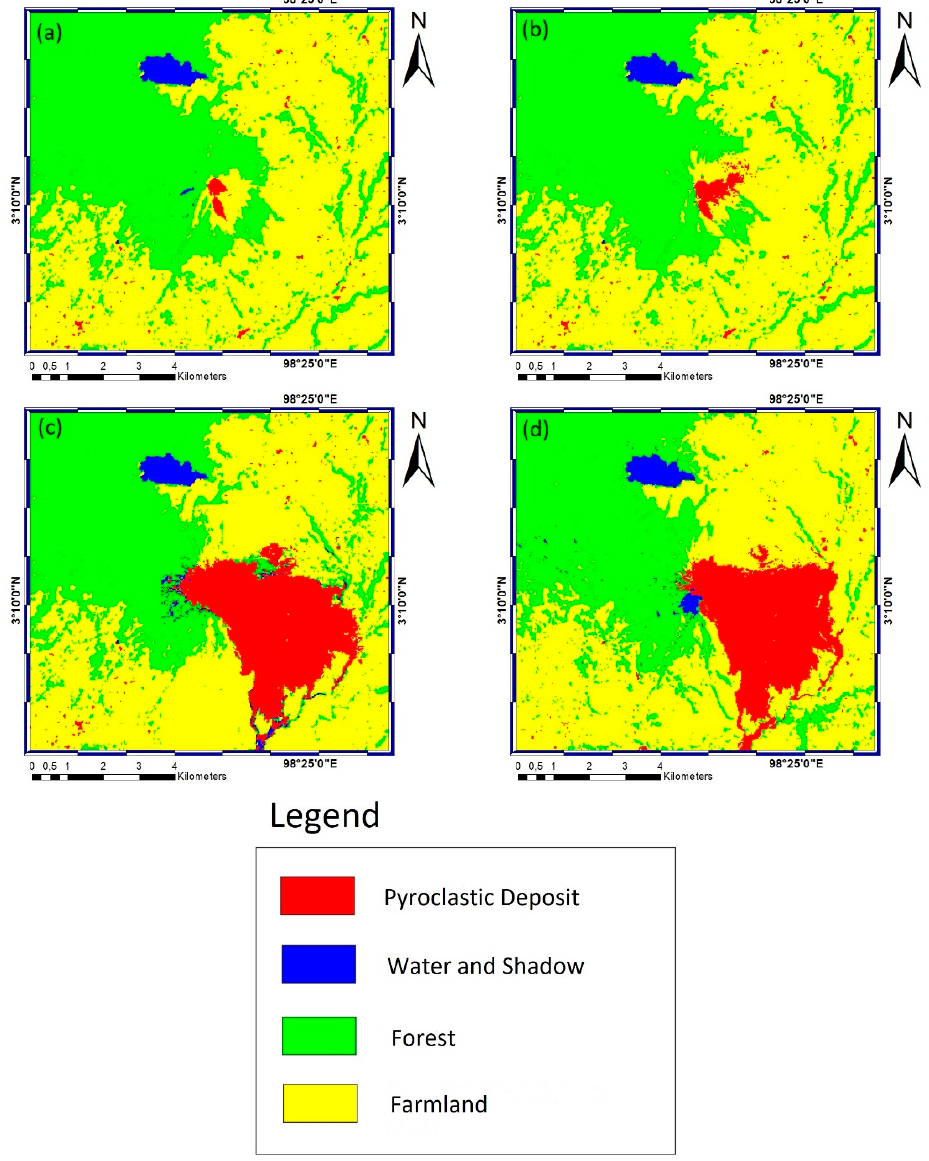
Figure 5. Supervised classification maps from ANN processing in the ENVI program of the Mount Sinabung Landsat Imagery taken on: ( a ) 7 February 2007; ( b ) 17 November 2011; ( c ) 1 July 2016; and ( d ) 28 July 2017.